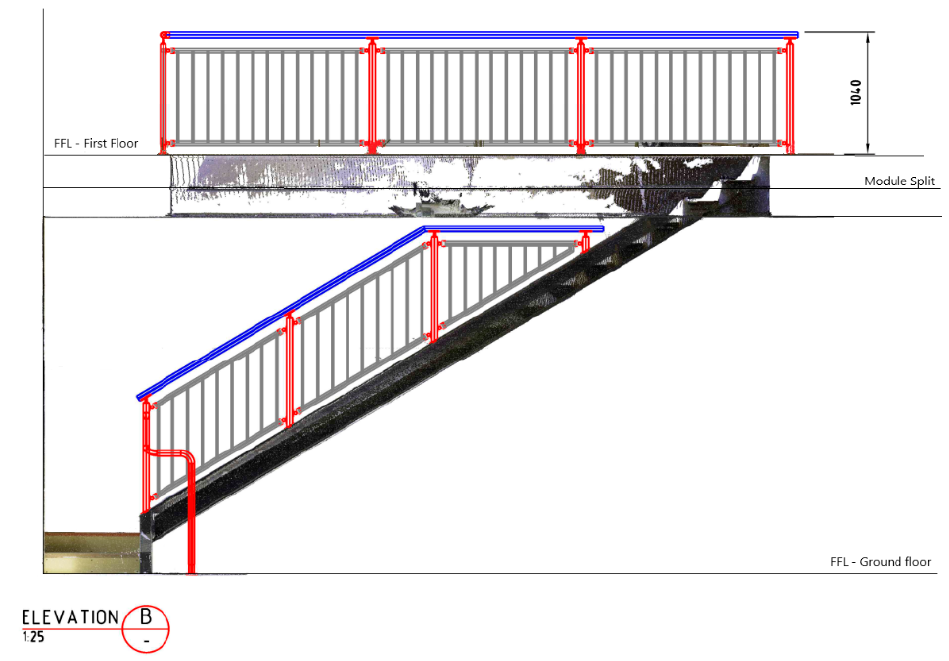
Figure 4. Balustrade design scan. The balustrade design fosters disassembly; the balustrade runs under the ceiling on the ground module and is selfcontained within the first floor module.